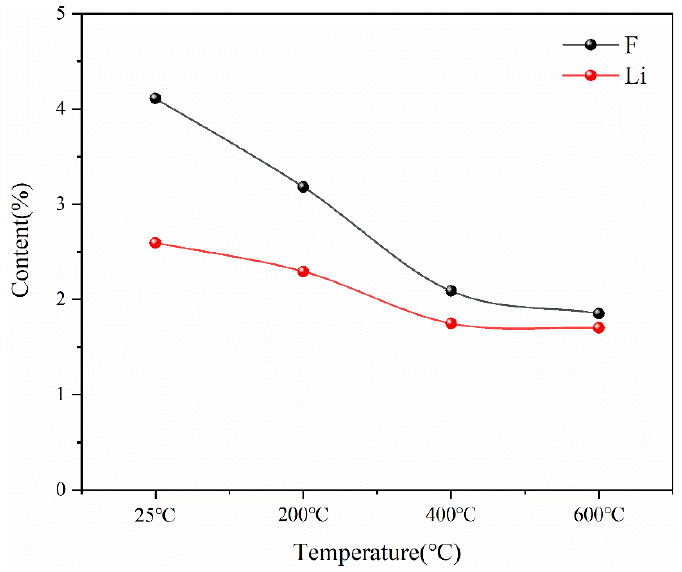
Figure 19. Content changes of F and Li in battery materials after pyrolysis at different temperatures.